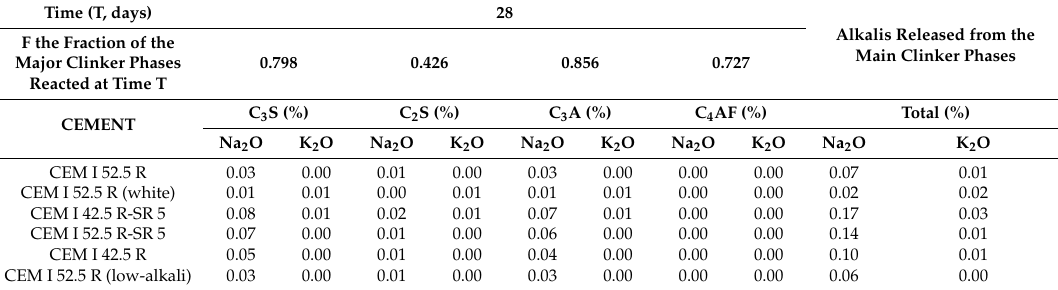
Table 8. Weight of Na 2 O or K 2 O released from each main phase at 28 days.